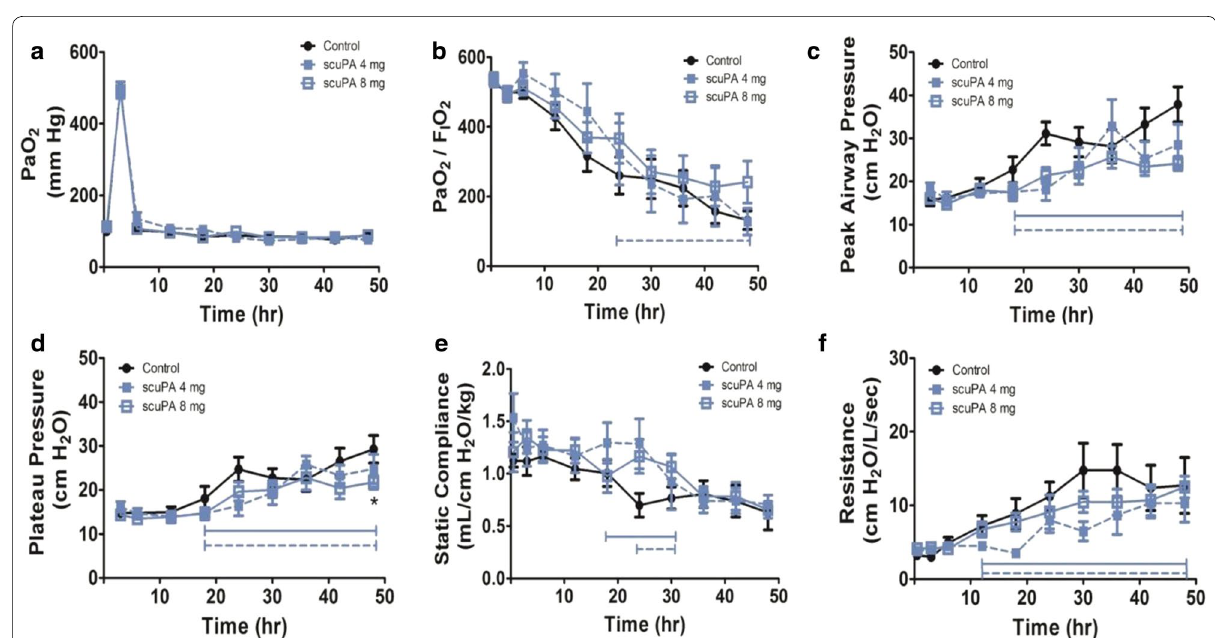
Fig. 4 Pathophysiologic effects observed in Group 2 sheep treated with nebulized scuPA. Data from saline vehicle nebulized controls (n 9) and = from sheep treated with nebulized scuPA at the 4 mg (n 5, including one animal that died prematurely) and 8 mg (n 8, including one animal = = which died prior to 48 h) (Fig. 1). a PaO 2 : arterial oxygen tension (mmHg): no significant differences between dosing levels and control. b PaO 2 / FiO 2 ratios: statistically significant increase for dosing at 8 mg compared to control (p 0.02), independent of time; but no significant difference at = 4 mg dosing. c Peak airway pressures (cmH 2 O) and d plateau airway pressures (cmH 2 O) were significantly reduced compared to controls over time (p < 0.001) at 8 mg and 4 mg scuPA. The asterisk in d shows a significant reduction of plateau pressures in the scuPA 8 mg group versus controls at the 48 h interval. e Static lung compliance (mL/cmH 2 O/kg) was greater compared with control overtime (p < 0.001), with scuPA 4 mg and scuPA 8 mg (p 0.02 in each case) treated groups greater than control, independent of time. f Lung resistance (L/cmH 2 O/min) was significantly decrease = compared to control overtime (p < 0.001), with scuPA 4 mg (p 0.01) and scuPA 8 mg (p 0.02) treated groups, independent of time. All depicted = = trends were statistically significant over time (p < 0.001). Statistical significance of treatment groups against controls is shown by solid (scuPA, 4 mg) or dashed (scuPA, 8 mg)